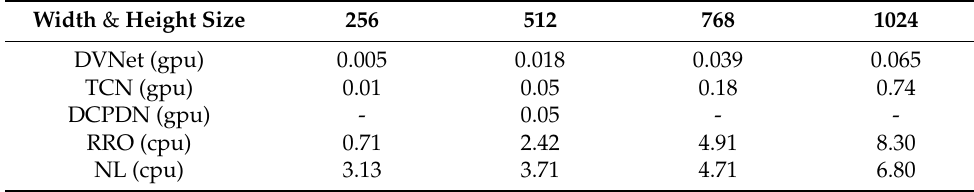
Table 7. Processing time (s) according to image